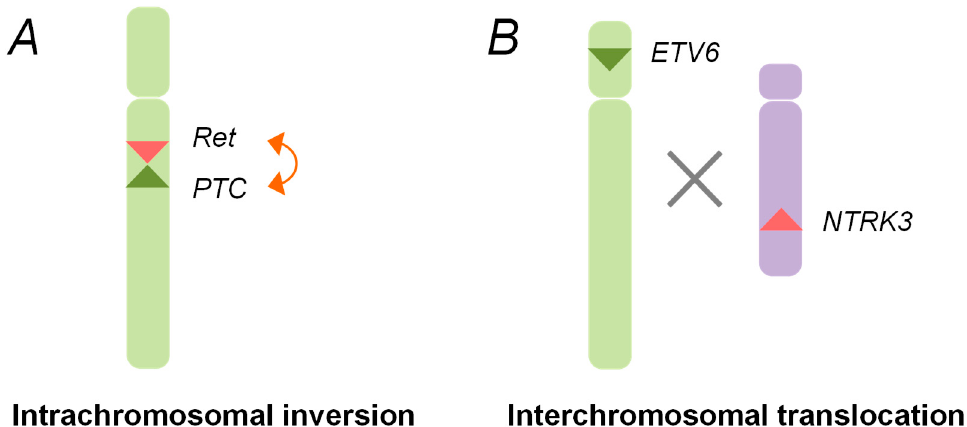
Figure 1. Schematic representation of oncogenic chromosomal rearrangements. ( A ) Intra-chromosomal inversion. The rearranged during transfection ( RET) gene and the PTC1 / 3 gene ( RET / PTC ) rearrangements are generated by an intra-chromosomal inversion of chromosome 10, which gives rise to the fusion genes between the tyrosine kinase domain of the RET gene and the amino terminal region of the PTC gene; ( B ) Inter-chromosomal translocation. The chromosomal rearrangements, such as ETV6-NTRK3, are created through an illegitimate recombination between the different broken chromosomes.